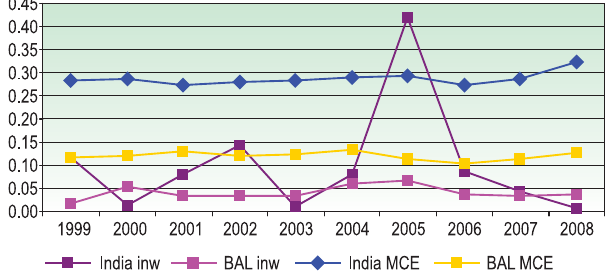
Fig. 11. FDI growth rates vs aggregated index MCE (the third